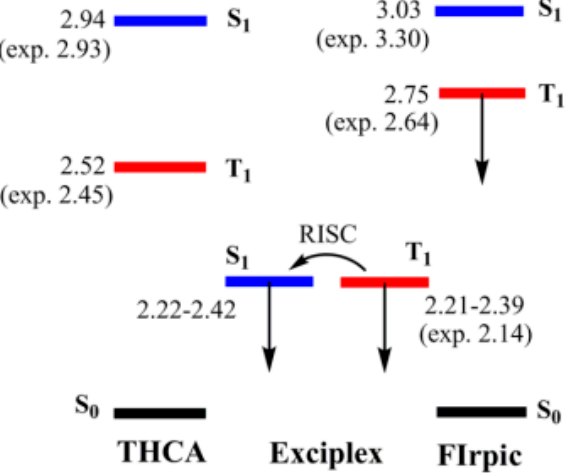
Figure 30. Energy diagram for the S 1 and T 1 states of THCA, FIrpic, and their mixture (THCA/FIrpic), which is responsible for the exciplex emission. Reprinted with permission from Reference [235].